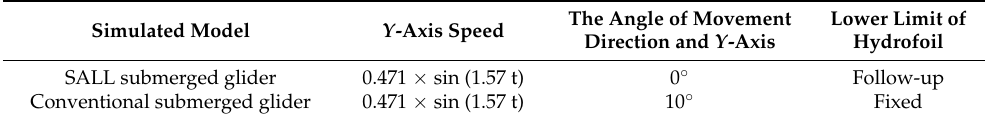
Table 7. The numerical simulations for the submerged